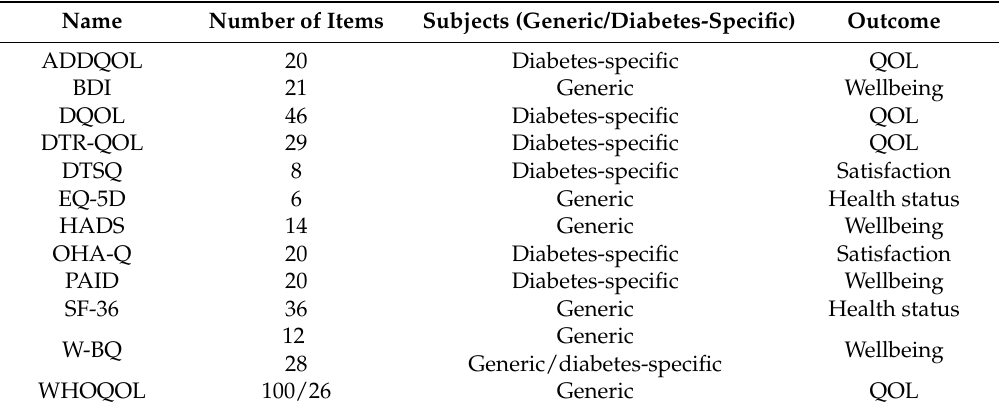
Table 1. Major questionnaires for PROs used internationally in patients with diabetes. This table was modified and adopted from reference